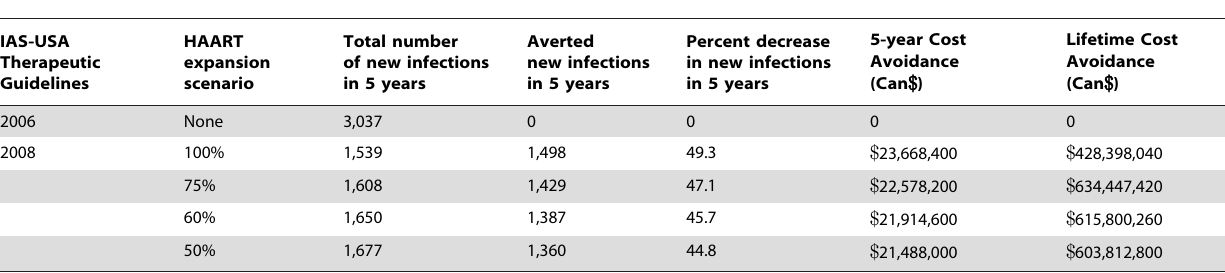
Table 1. Effect of HAART expansion on the projected number of new HIV infections and HIV infections averted in the next 5 years, by different